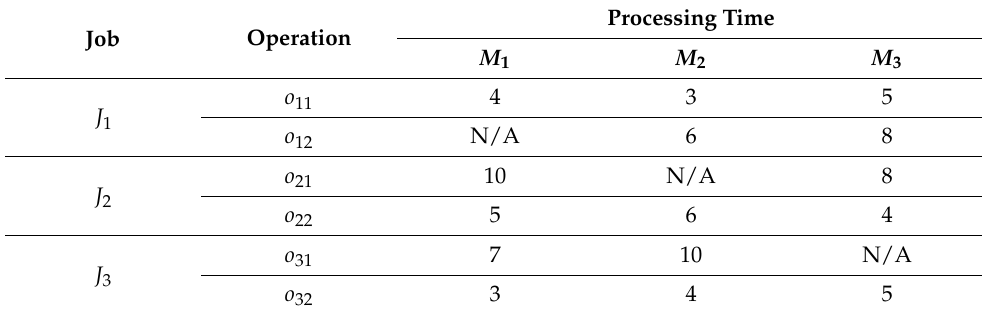
Table 2. An example of the FJSP.